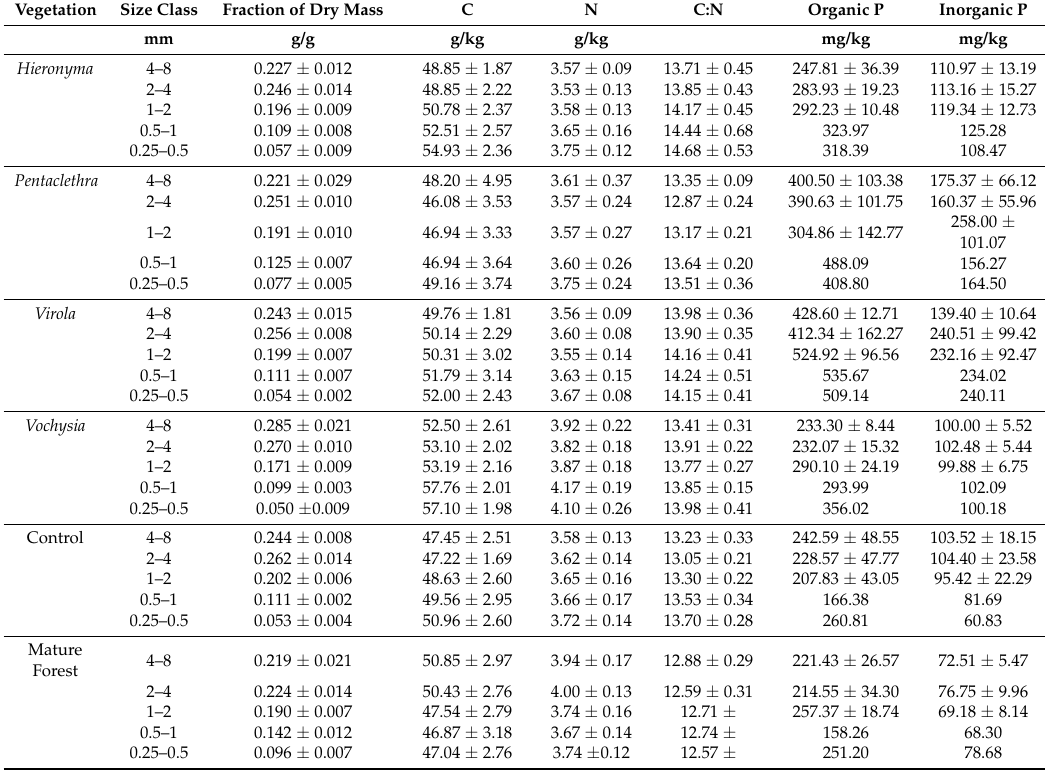
Table A1. Macroaggregate dry mass and elemental concentration by diameter size class and vegetation type in experimental site in Costa Rica. ‘Fraction’ refers to the proportion of the total dry soil mass recovered after wet sieving. Means ( ± S.E.) are for n = 4 samples (3 in Vochysia ) from the 0–15 cm depth. Vegetation Size Class Fraction of Dry Mass C